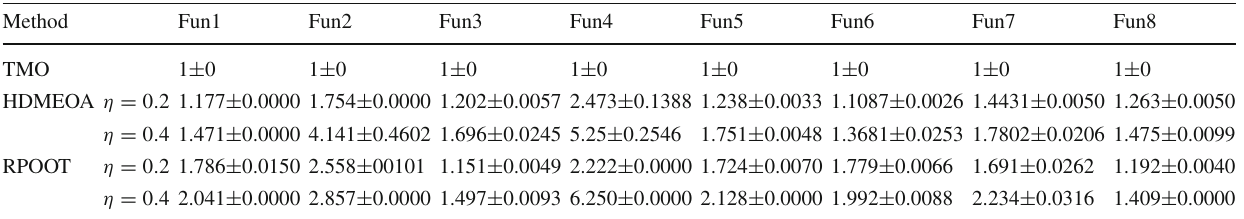
Table 10 MRST comparison of three methods under stochastic environmental changes Method